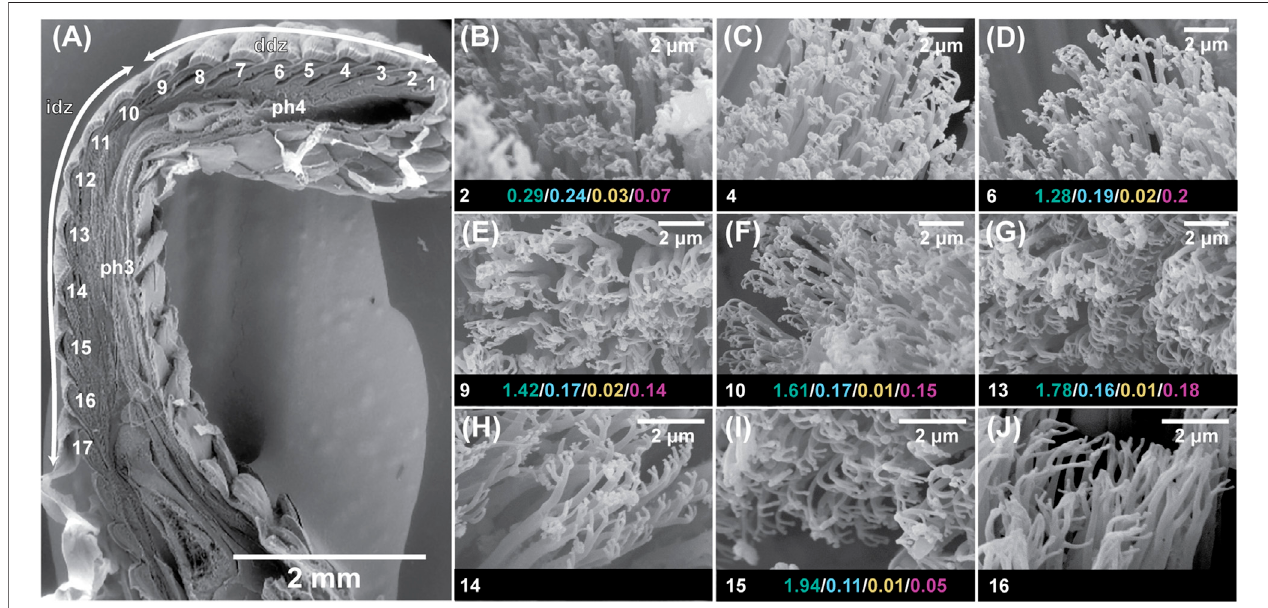
FIGURE 4 | Scanning electron microscopic visualization of the sagittally-sectioned fourth digit of the right manus of the Tokay gecko, Gekko gecko . Panel (A) is identical to panel (A) in Figure 3 . Panels (B) – (J) depict enlargements of the fi laments carried on each plate. For scansors/lamellae 2, 6, 9, 10, 13, and 15 the following data are provided: scansor/lamella surface area (mm 2 ) in green/average setal tip width (µm) in blue/average setal tip area (µm 2 ) in yellow/total setal tip area per scansor/ lamella (mm 2 ) in purple. Data from Russell et al. (2007).